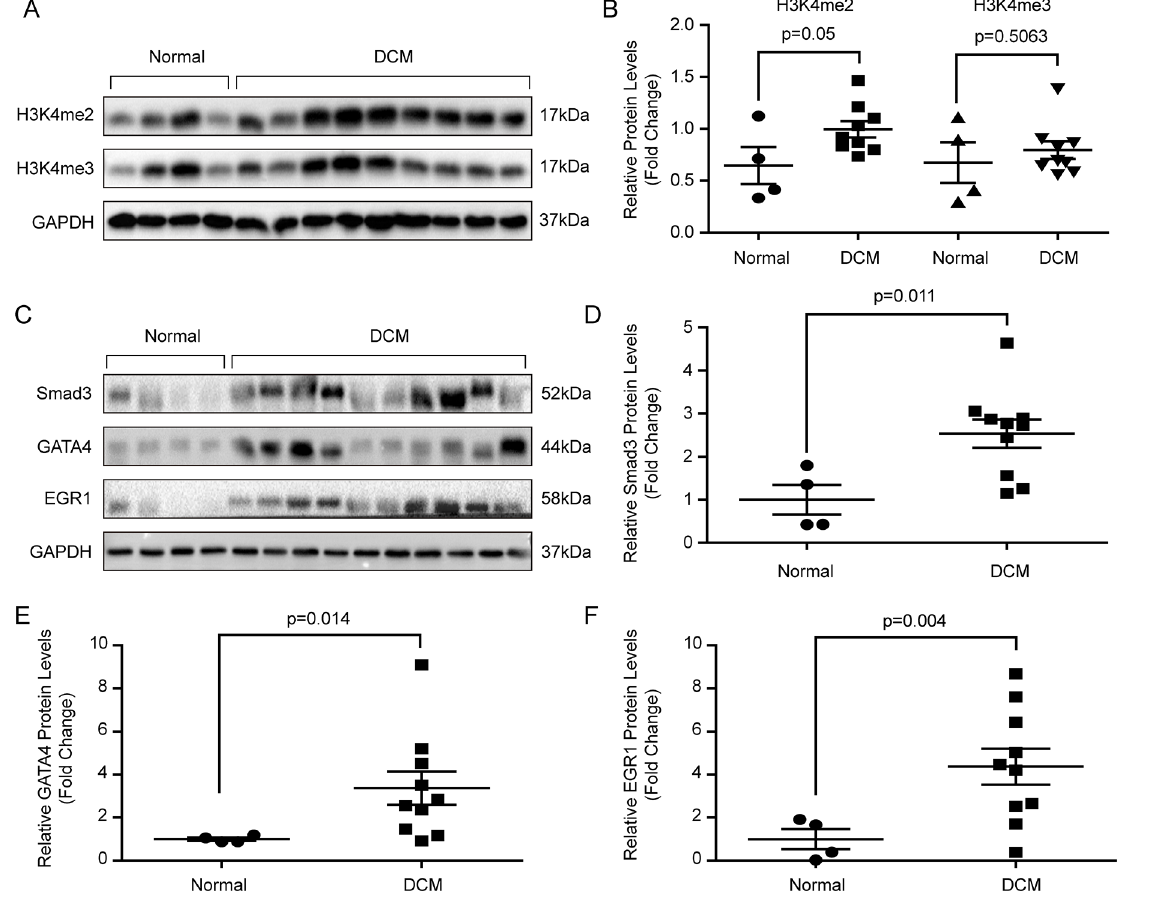
Figure 5. Protein levels of H3K4me2/3, Smad3, GATA4 and EGR1 in human hearts. (A) Di- and trimethylation of H3K4 was detected by Western blot (n = 4–9 per experimental group). (B) The quantitative results of panel A. (C) Protein levels of Smad3, GATA4 and EGR1 were detected via Western blot (n = 4–10 per experimental group). (D–F) The quantitative results of panel